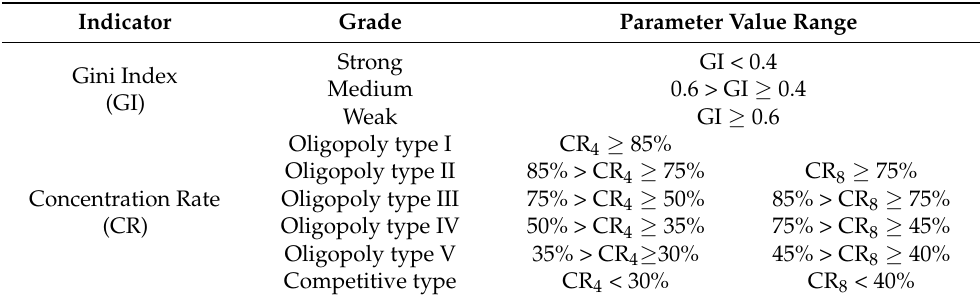
Table 1. Classification standards of spatial heterogeneity and agglomeration.